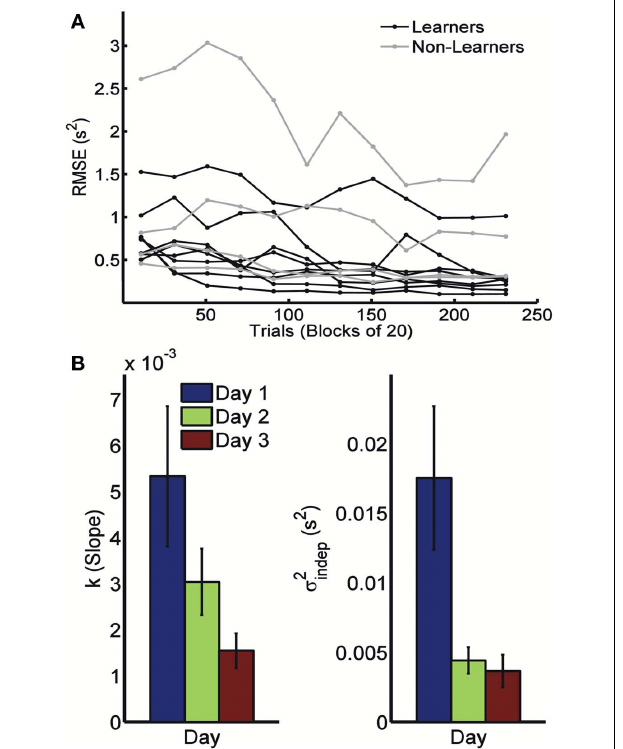
FIGURE 2 | Learning in the spatiotemporal pattern reproduction task. (A) Learning curves. Performance of all subjects over 3days of training. RMSE: root-mean-square error between response times and target times, averaged in blocks of 20 trials. Statistically significant learners are in black, non-learners in gray. Some subjects classified as non-learners had very low RMSE values, but did not exhibit any significant improvement in performance from the first to last block, and were thus classified as “non-learners” (see Materials and Methods). (B) Mean slope k and mean intercept σ 2 across the 3-days of training. Error bars represent the SEM. indep There was a significant decrease in both k and σ 2 across training days indep ( p = 0.013 and 0.011,